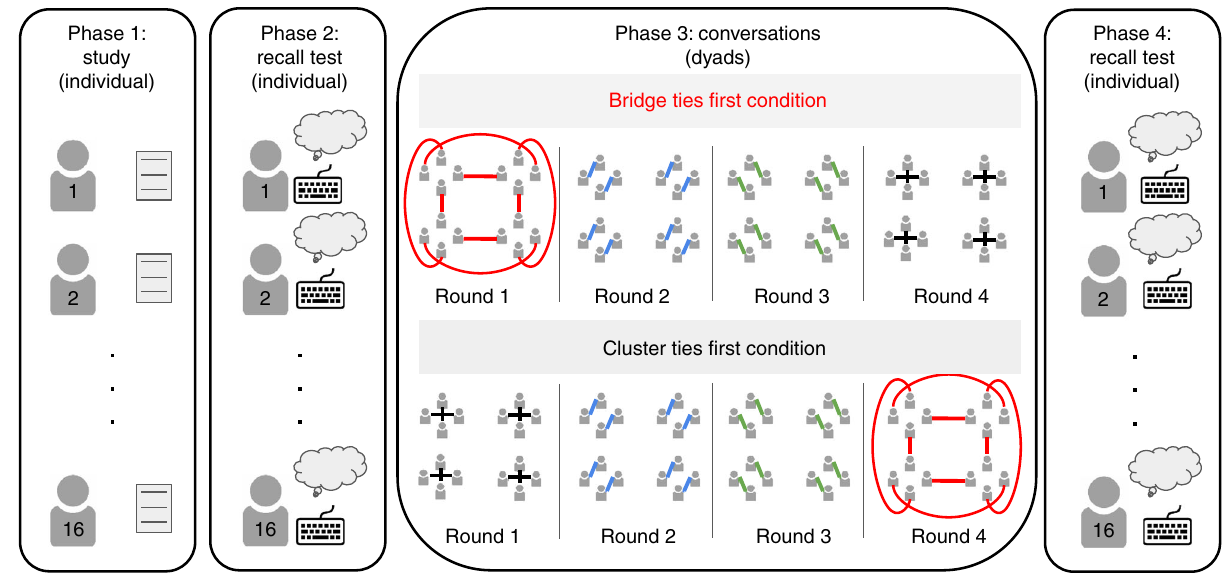
Fig. 2 Phases of the experimental procedure. Each experimental session had four phases. In phase 1, all 16 participants that comprised a lab-created community studied the material (see Supplementary Methods) alone, and in phase 2 (as in phase 4), each participant engaged in individual free recall by typing their recollections on the computer. In phase 3, the nodes represent 16 participants and the edges represent conversations between two individuals. The order of the conversations in phase 3 depended on the condition: in the Bridge Ties First condition participants have their fi rst conversation across clusters, whereas in the Cluster Ties First condition they have their fi rst conversation within clusters. The Keyboard image is from http://icons8.com. All rights